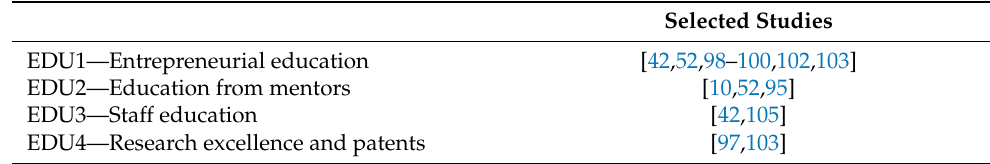
Table 3. Construction of the education and research factor from the literature.